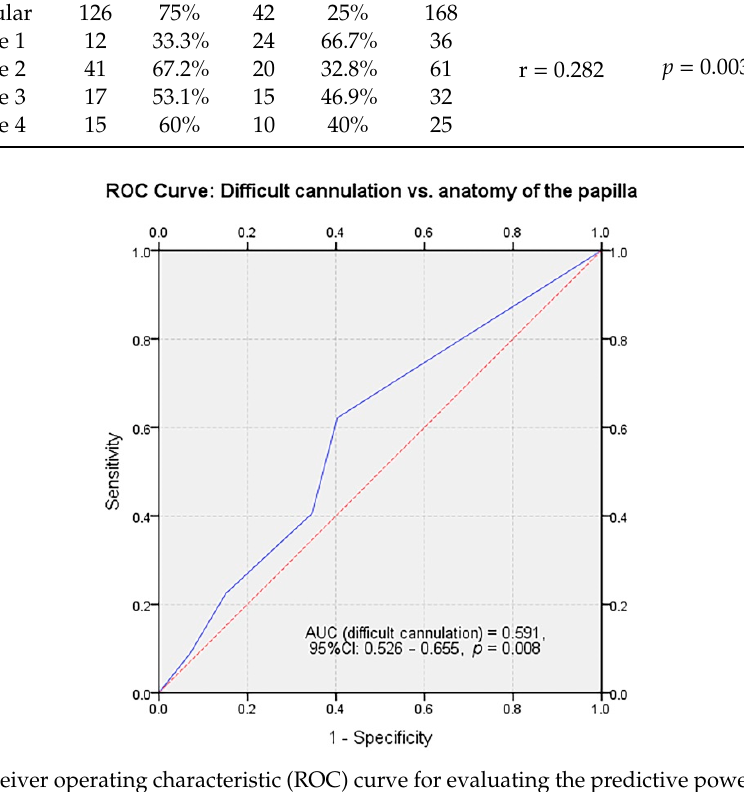
Figure 3. Receiver operating characteristic (ROC) curve for evaluating the predictive power of different papilla types on the rate of difficult cannulation.